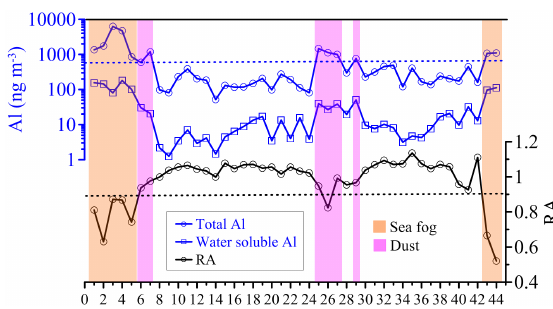
Figure 3. Total and water-soluble Al concentrations and relative acidity (RA) for TSP. The orange bars indicate the sea fog period, and the pink bars indicate the dust period. Sample identifications are shown on the x axis (see Table S1). The horizontal blue dashed line (590ngm − 3 ) stands for the reference to define background aerosols, and black dashed line indicates the criterion of 0.9 for rel- ative